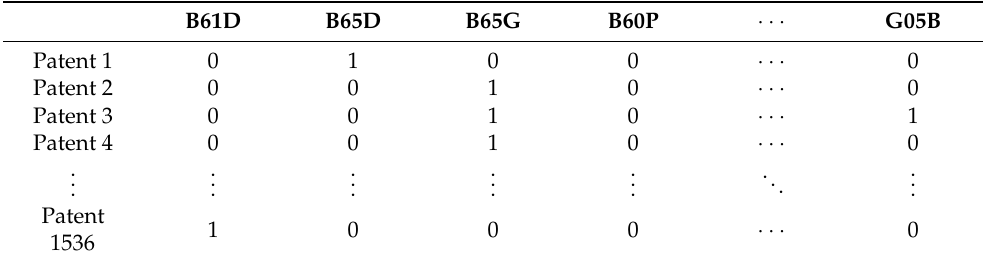
Table 1. The format of the international patent classification (IPC) vectors.